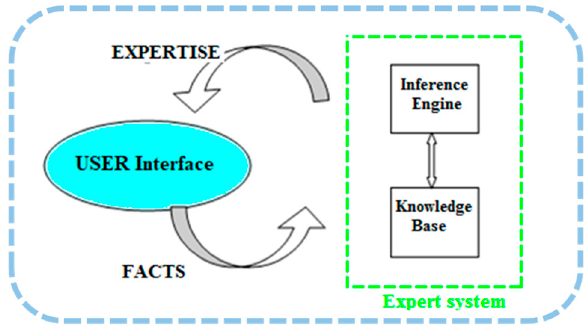
Figure 2. The basic concept of ES operation.